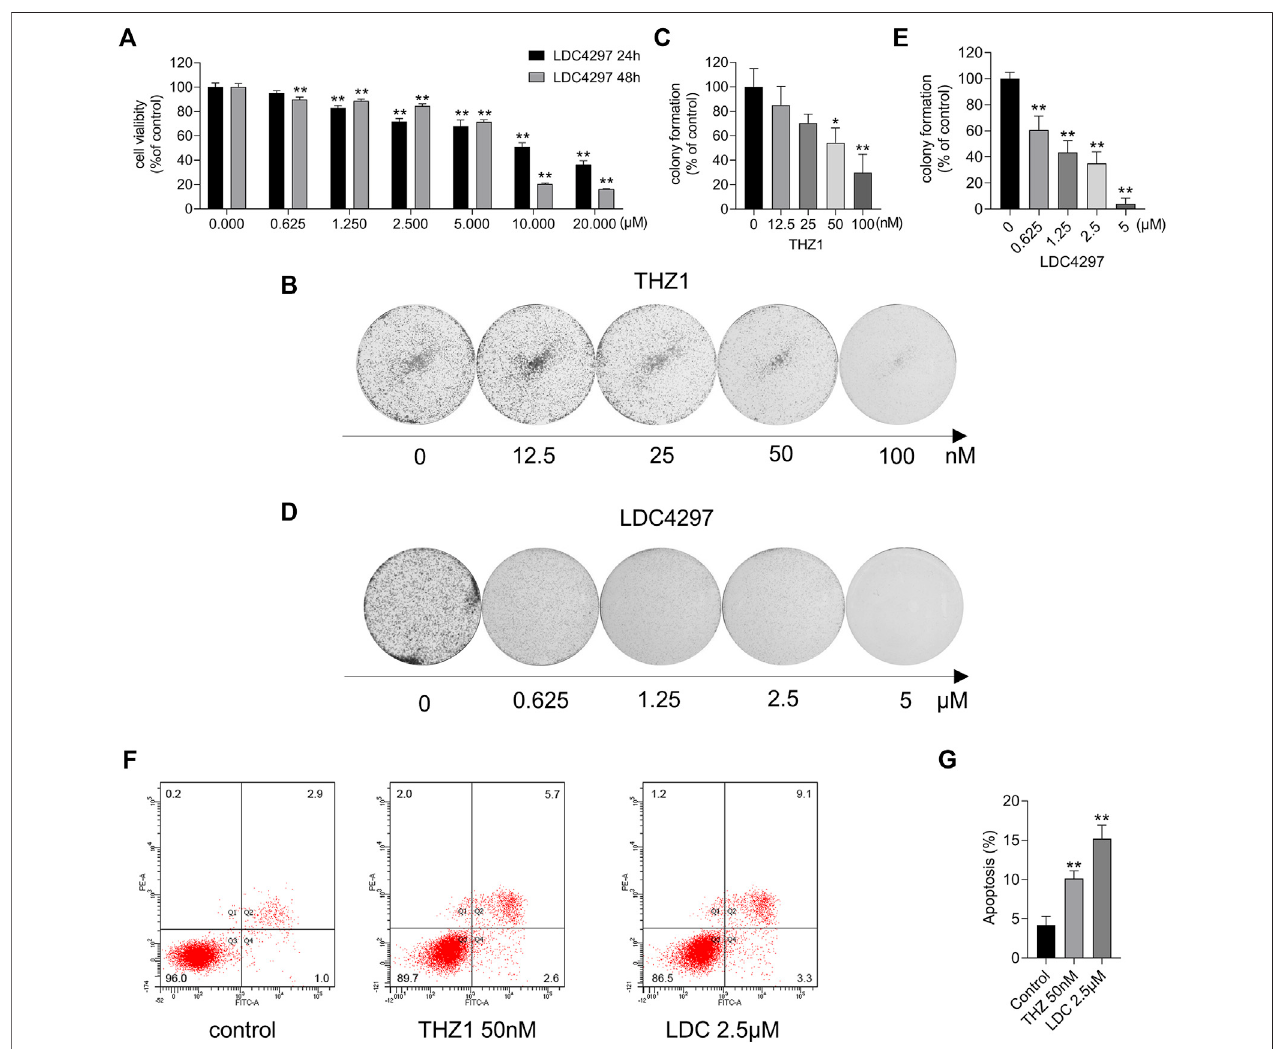
FIGURE 1 | CDK7 inhibitors affected MCF-7 cell survival. (A) The cell viability was detected by the CCK8 assay after MCF-7 cells were treated with increasing concentrations of LDC4297 for 24 or 48 h separately. (B, D) The colony formation ability was detected after MCF-7 cells were treated with THZ1 or LDC4297. (C, E) Quantitation of colony formation ability in (B) and (D) separately. (F) Apoptosis was analyzed by fl ow cytometry after MCF-7 cells were treated with 50 nM THZ1 or LDC4297 2.5 μ M for 24 h. (G) Quantity of apoptosis in (F) . Statistically signi fi cant: * p < 0.05; ** p < 0.01.